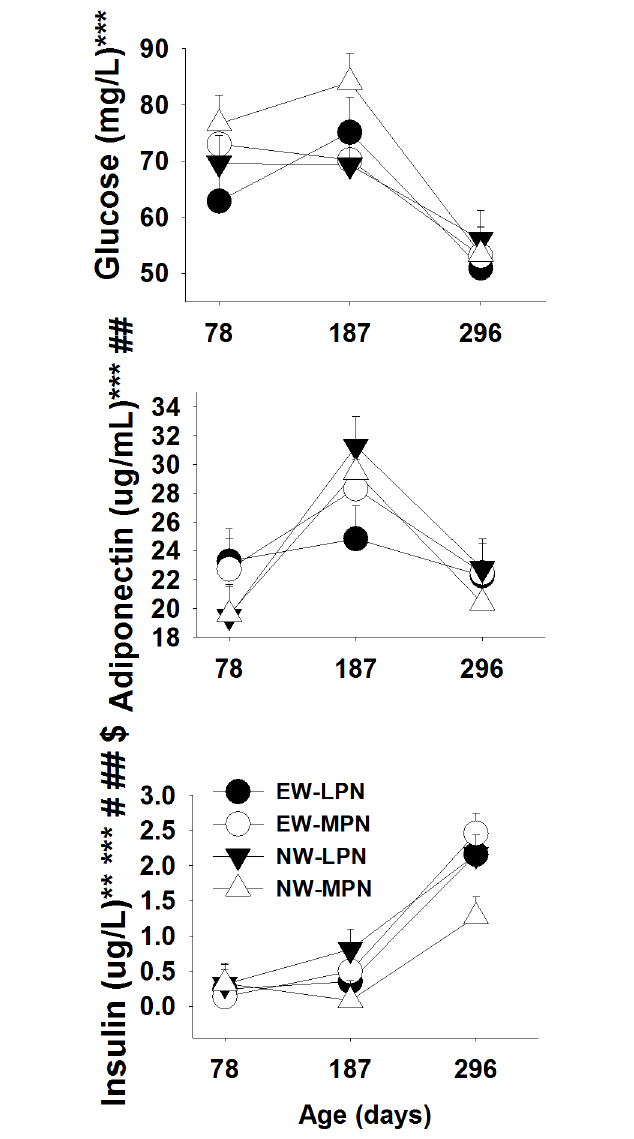
Fig 1. Glucose, adiponectin and insulin serum concentrations in Angus × Simmental steers from cows that received a low (LPN) or medium (MPN) plane of nutrition during the late gestation period. Weaning times are early wean (EW) and normal wean (NW). * Weaning, ** Diet, *** Time, # weaning × diet, ## weaning × time, ### diet × time and $ time × weaning × diet interaction effects ( P < 0.05).